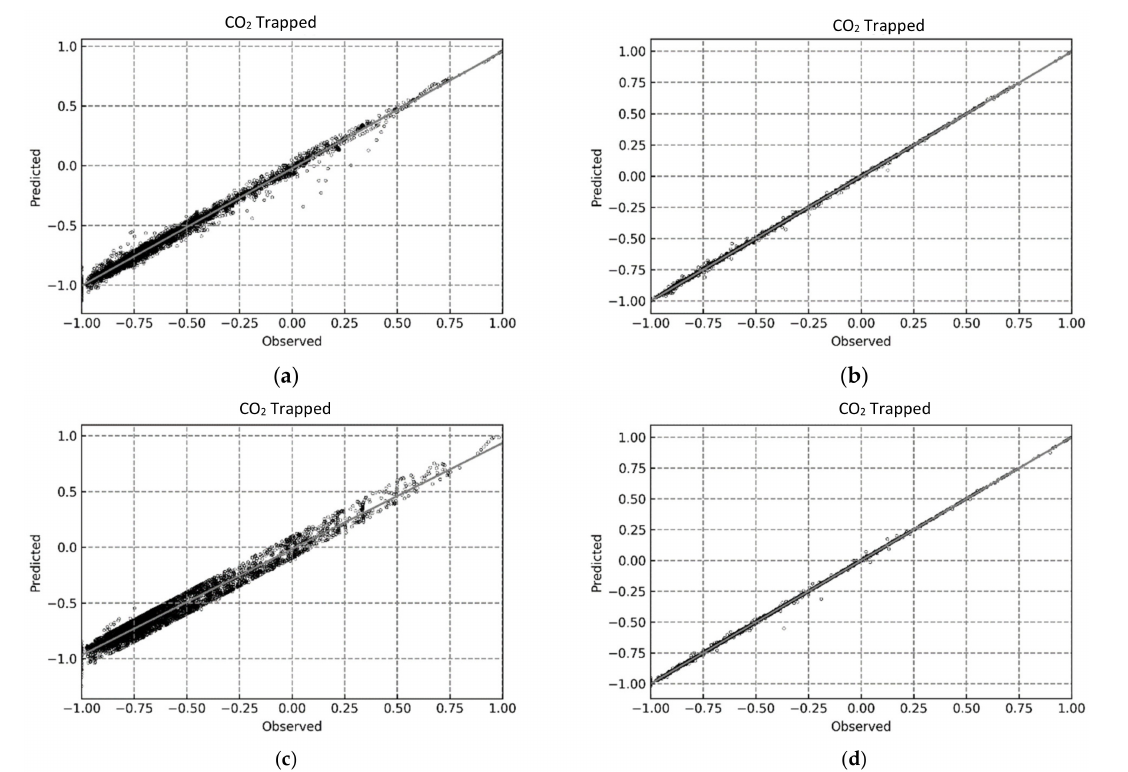
Figure 13. Predicted vs. Observed plots for determining CO 2 trapped using the proposed ML-based models. ( a ) MLP; ( b ) RF; ( c ) SVR; ( d )